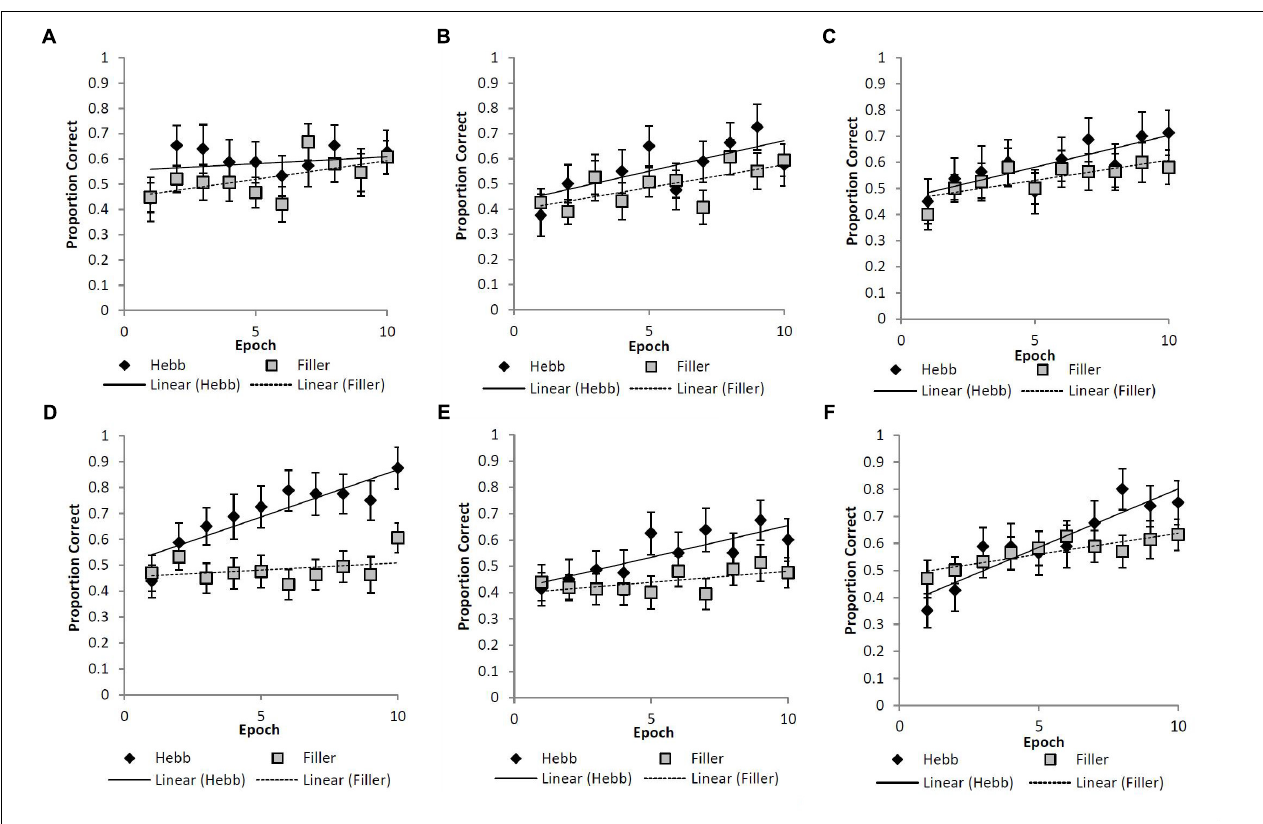
FIGURE 4 | (A–F) Mean proportion correct recall scores for the filler and Hebb sequences as a function of experimental epoch (1–10) for the (A) upright faces under conditions of full-stimulus-overlap, (B) inverted faces under conditions of full-stimulus-overlap, (C) abstract matrices under conditions of full-stimulus-overlap, (D) upright faces under conditions of no-stimulus-overlap, (E) inverted faces under conditions of no-stimulus-overlap, and (F) abstract matrices under conditions of no-stimulus-overlap. Line of best fit depicts the learning gradient for both sequence types. Error bars represent the standard error of the means.